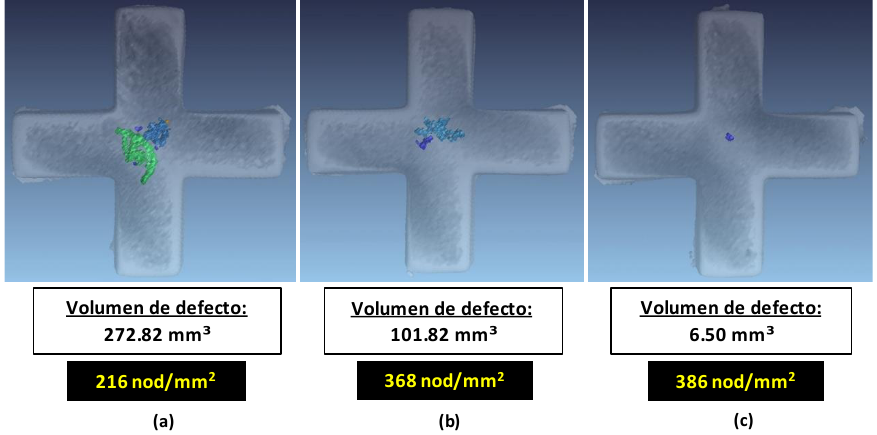
Figure 5. Evaluation of microporosity by tomography in cross-shaped castings from Heat 3: ( a ) non-inoculated; ( b ) inoculated with Ce-inoculant; ( c ) inoculated with Ce-inoculant + Se.